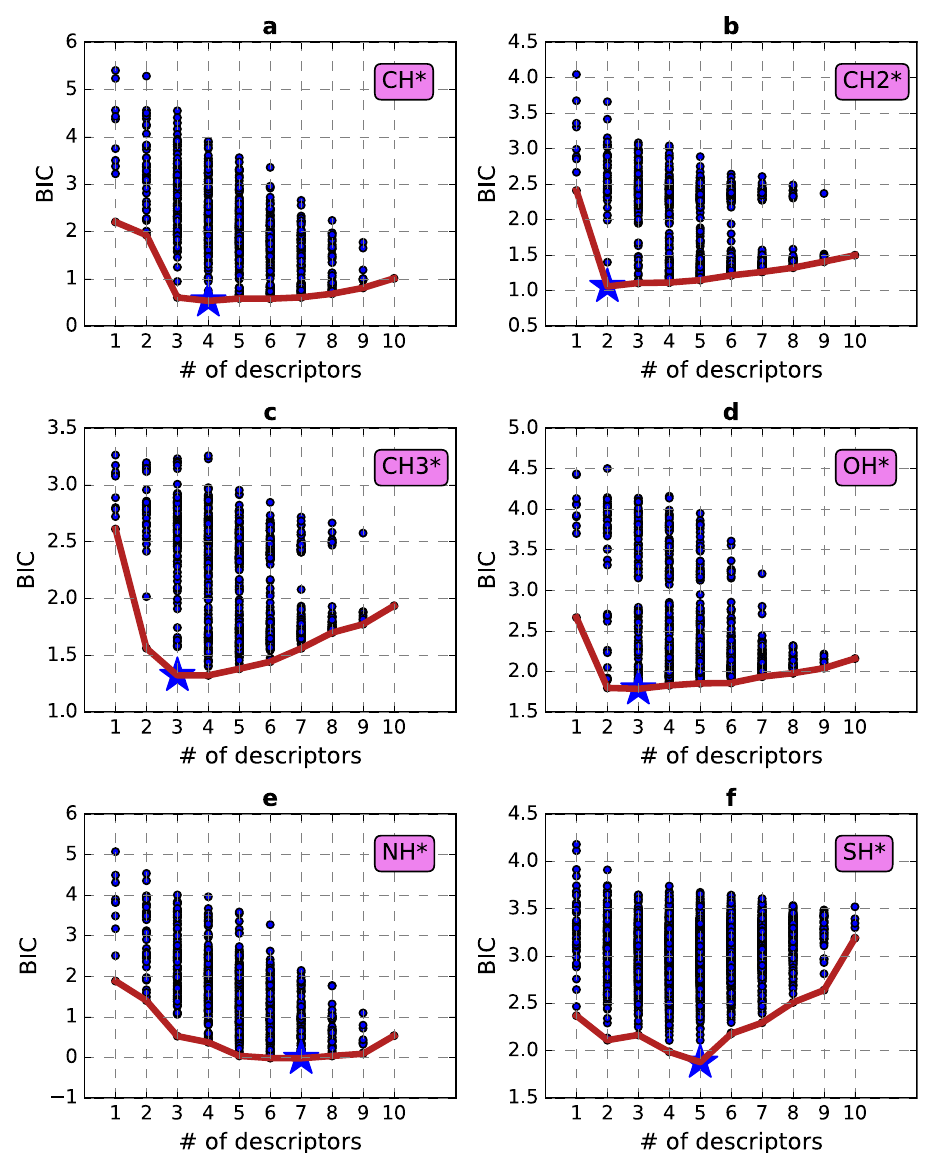
Fig. 2 Bayesian information criteria ’ s (BIC) are plotted against the number of parameters used for different multi-atoms adsorbates for a synthetic dataset containing 100 data points for each model. a CH *, b CH 2 *, c CH 3 *, d OH *, e NH *, and f SH *. The red line connects the minimum of each descriptors (BIC envelope). The blue star indicates the best model (with the lowest BIC